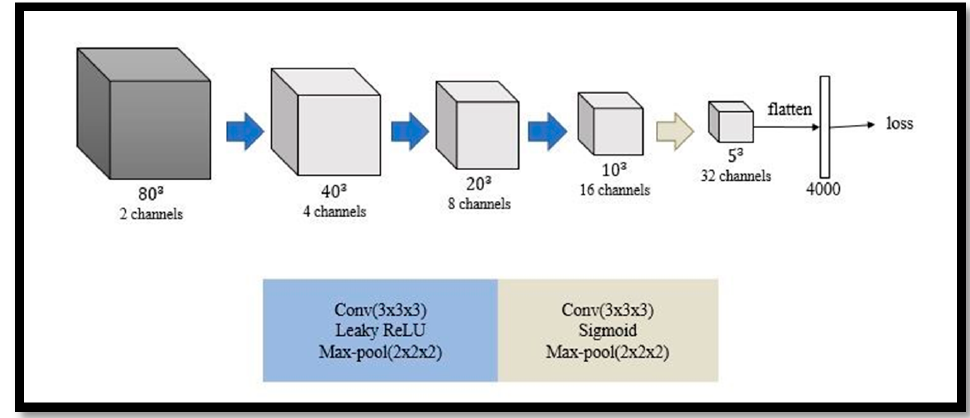
Figure 6. Network architecture of critic where Leaky ReLU is a modified ReLU function to allow positive values and small negative values.